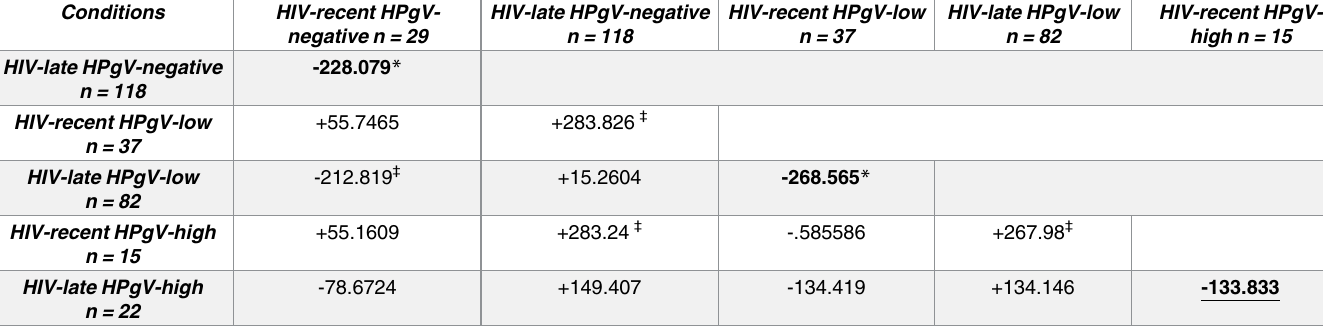
Table 3. Mean difference of CD4 + cell counts (CD4 + /mm 3 ) in co-infected subjects according to time of HIV infection and HPgV viral load